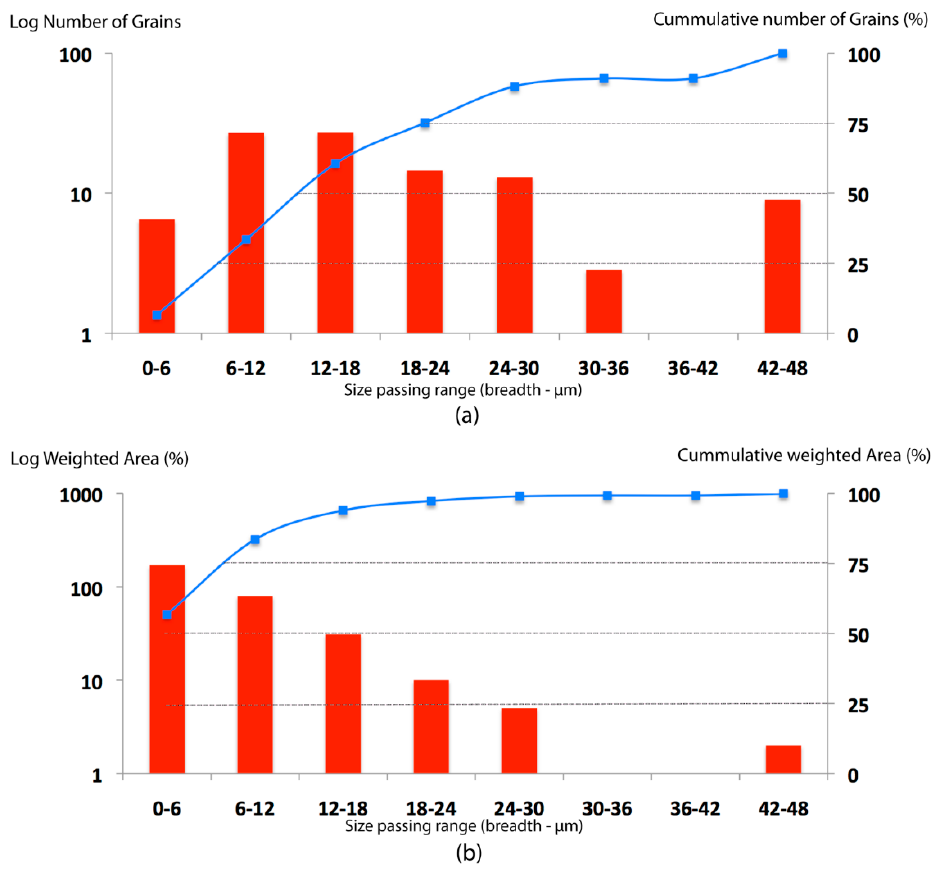
Figure 9. Ore samples: MB-21 and MB-21b. ( a ) X-axis vs. left Y-axis: frequency diagrams of number of gold-grains (log scale) related to gold size passing classes (breadth, µm) with red-bars. X-axis vs. right Y-axis: cumulative number of gold grains (%) related to gold size passing classes (breadth, µm) with blue-points. Dash lines represent percentiles 25, 50 and 75. ( b ) X-axis vs. left Y-axis: frequency diagrams of weighted gold-grain area (log scale) related to gold size passing classes (breadth, µm) with red-bars. X-axis vs. right Y-axis: cumulative weighted gold area (%) related to gold size passing classes (breadth, µm) with blue-points. Dash lines represent percentiles 25, 50 and 75.